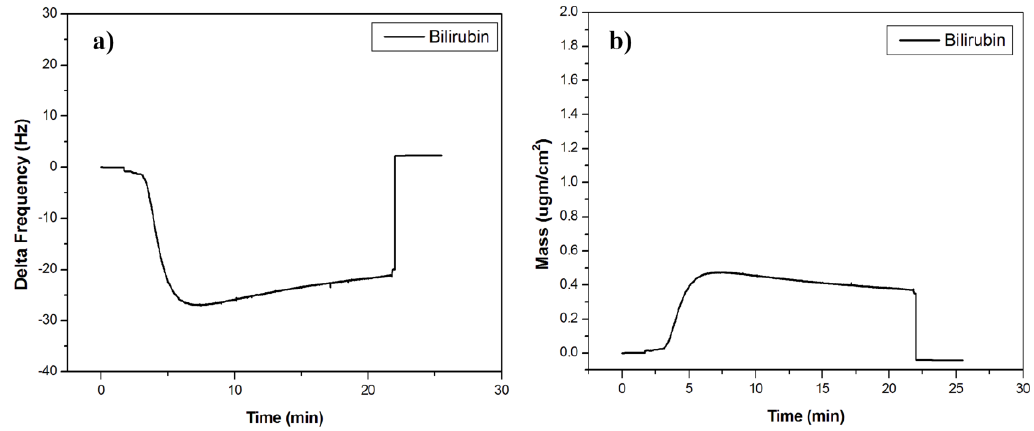
Figure 4. Real-time response of QCM sensor against aqueous solutions of bilirubin of 25 µg/mL and ( a ) the change of ∆f with time; ( b ) the change of mass with time.